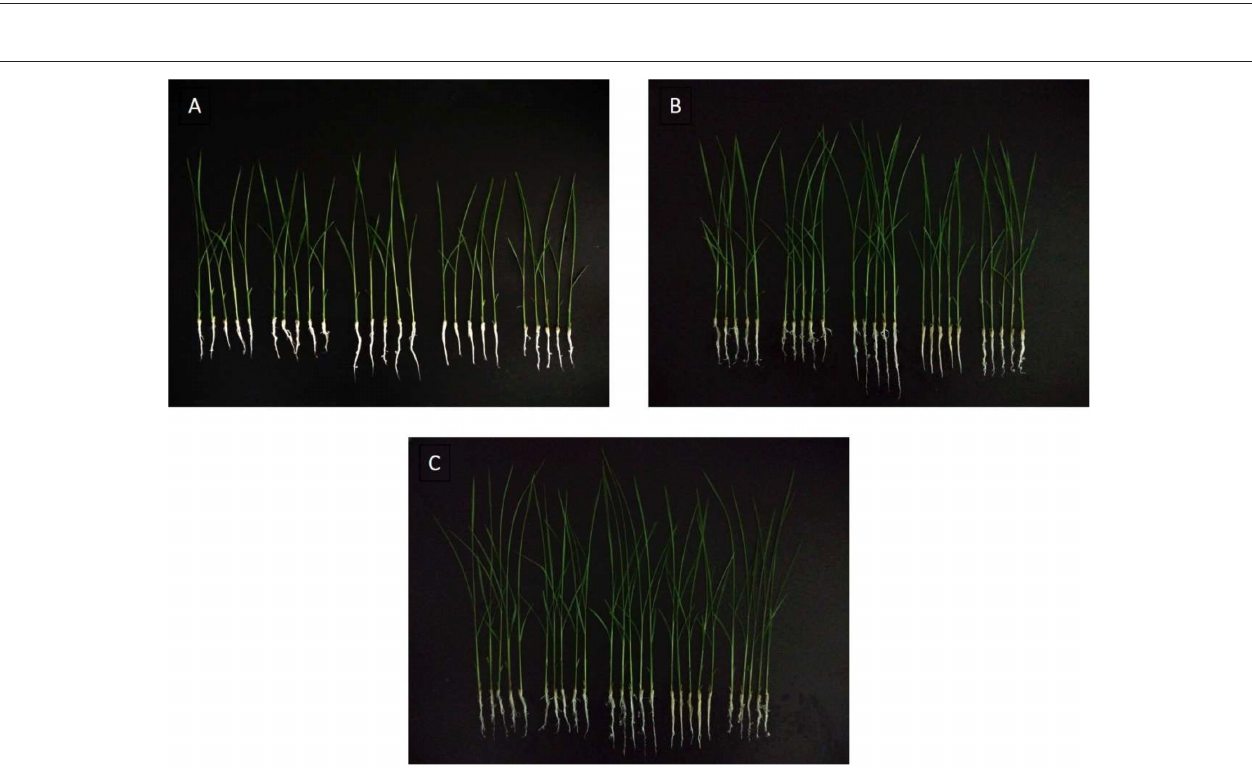
FIGURE 8 | Rice seeds treated with a range of concentrations of MoHrip1 show significant differences in their growth morphological characterization. (A) Rice seed germination after 9 days of treatment. (B) Rice seeds germinated after 11 days of treatment. (C) Rice seeds germinated after 13 days of treatment. The group arranged horizontally in each graph indicates the different concentrations of MoHrip1 used to treat the rice seeds (0, 2.5, 5, 10, and 20 µ g/mL, from left to right).